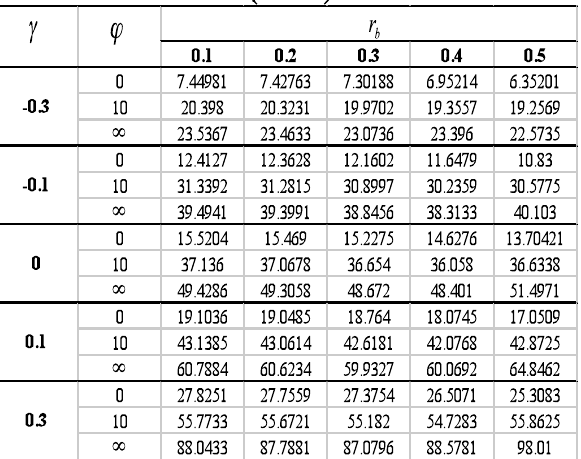
Table 4. Buckling load factor variation with edge